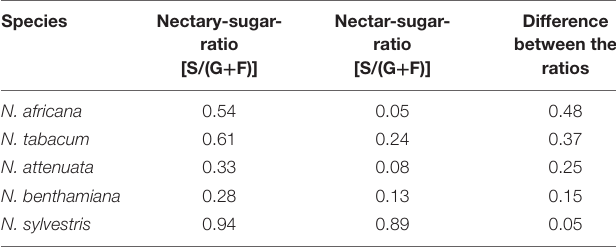
TABLE 1 | Nectary- and Nectar-sugar-ratios (calc. from mM) Data were derived from Figures 2 , 3 , the values of all measuring points were averaged. Species Nectary-sugar- Nectar-sugar- Difference ratio ratio between the